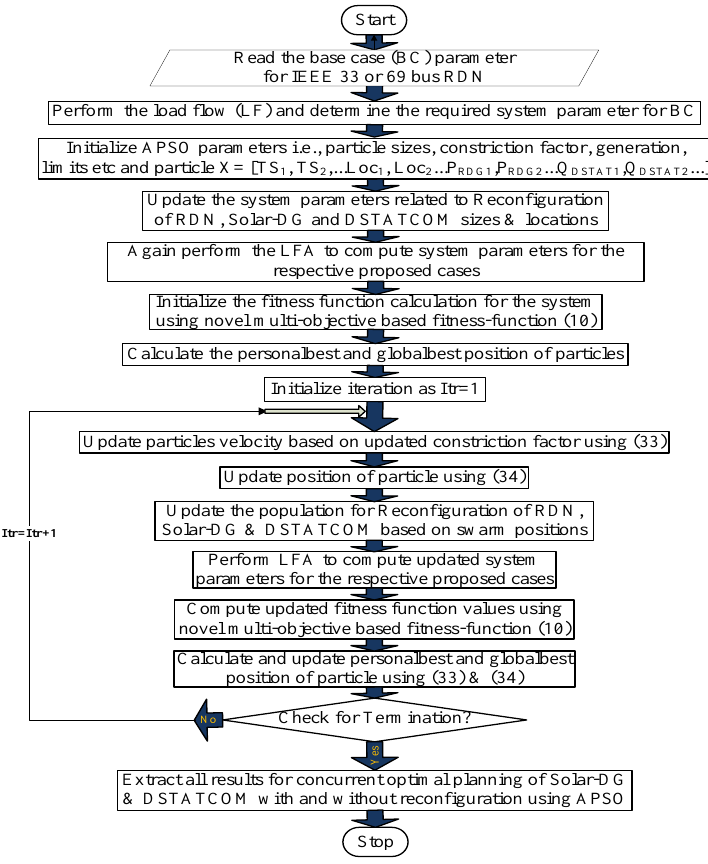
Figure 7. Flowchart for concurrent planning of multi Solar-DG and DSTATCOM in a reconfigured RDN using APSO technique.